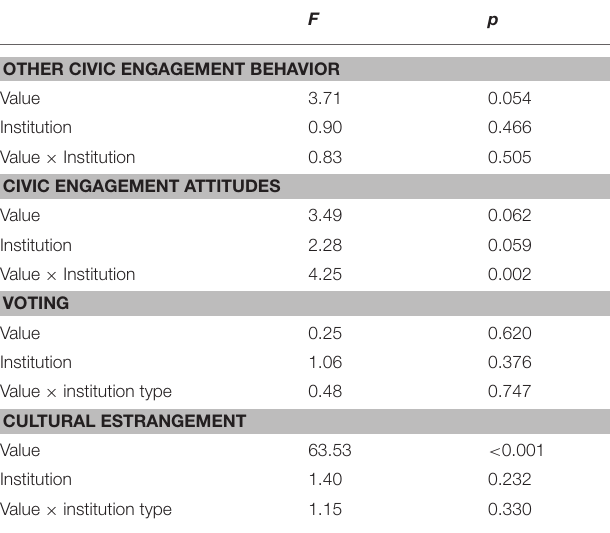
TABLE 5 | Test statistics from predicting cultural estrangement and civic engagement behaviors and attitudes from perceived values encouraged by institutions, institution types, and their interaction, Study